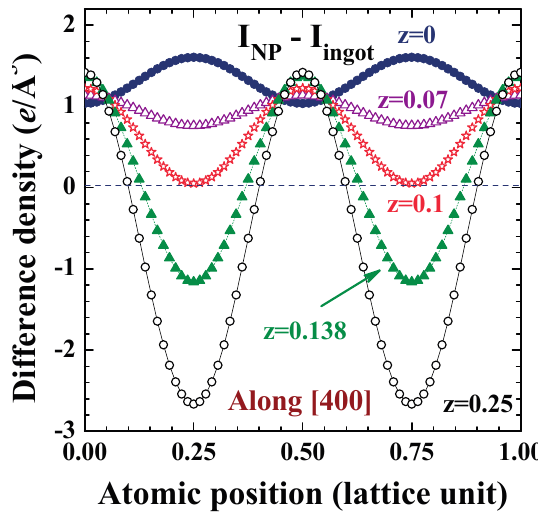
Figure 7. Difference of the electronic charge density between the 6.6 nm Cu assembly and 2 mm Cu ingot along the (400) crystallographic directions at z = 0 (filled circles), 0.07 (open triangles), 0.1 (open stars), 0.138 (filled triangles), and 0.25 (open